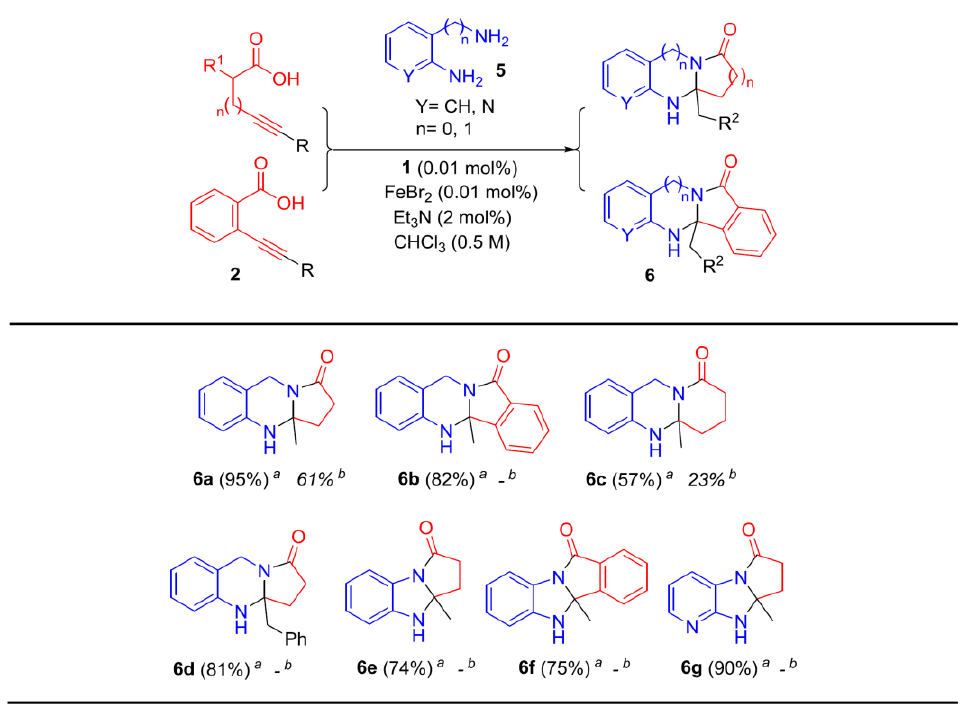
Figure 5. Palladium-catalyzed cascade reaction between alkynoic acids and diamines.